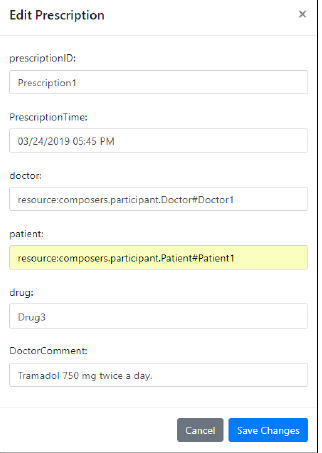
Figure 22. Update prescription